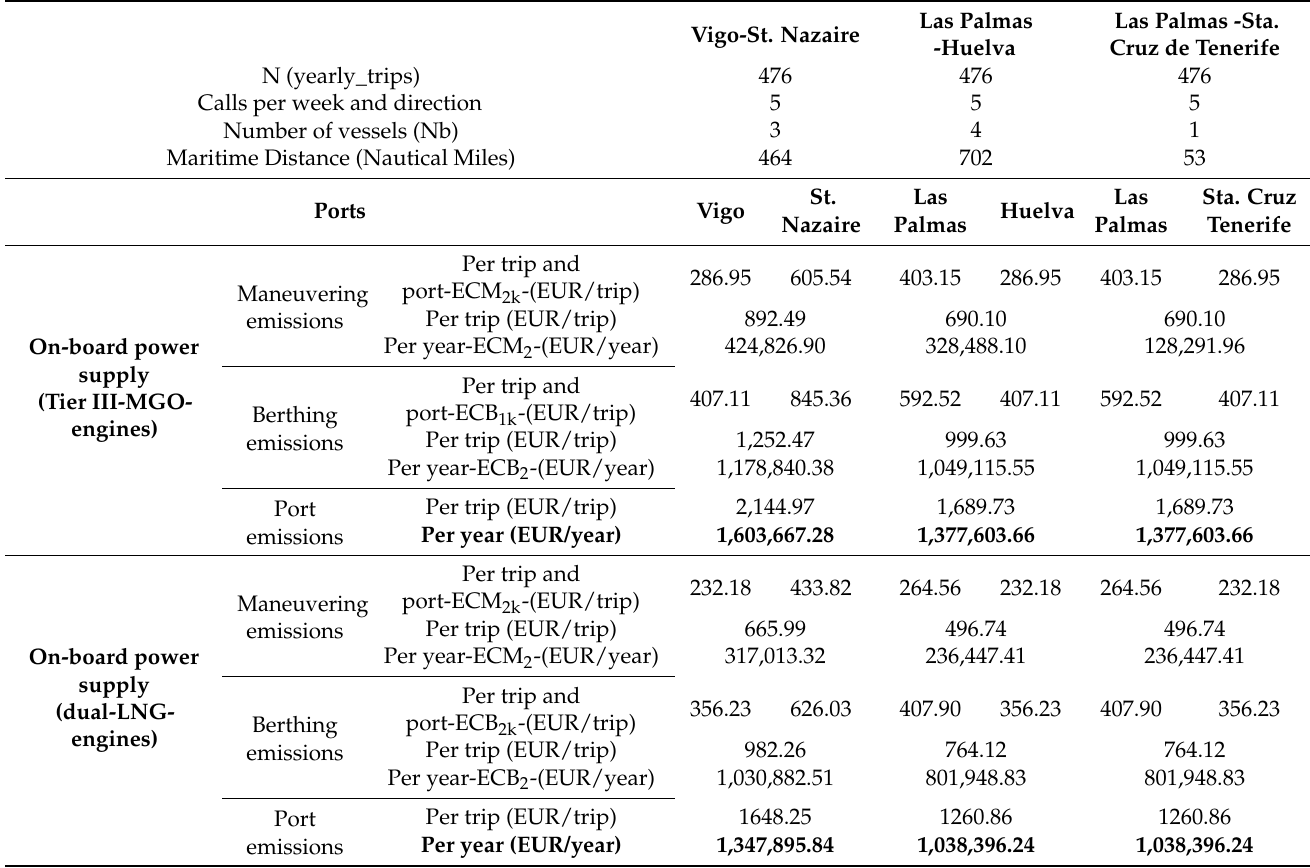
Table 7. Emissions reduction in Ro-Pax vessels by port mitigation alternatives